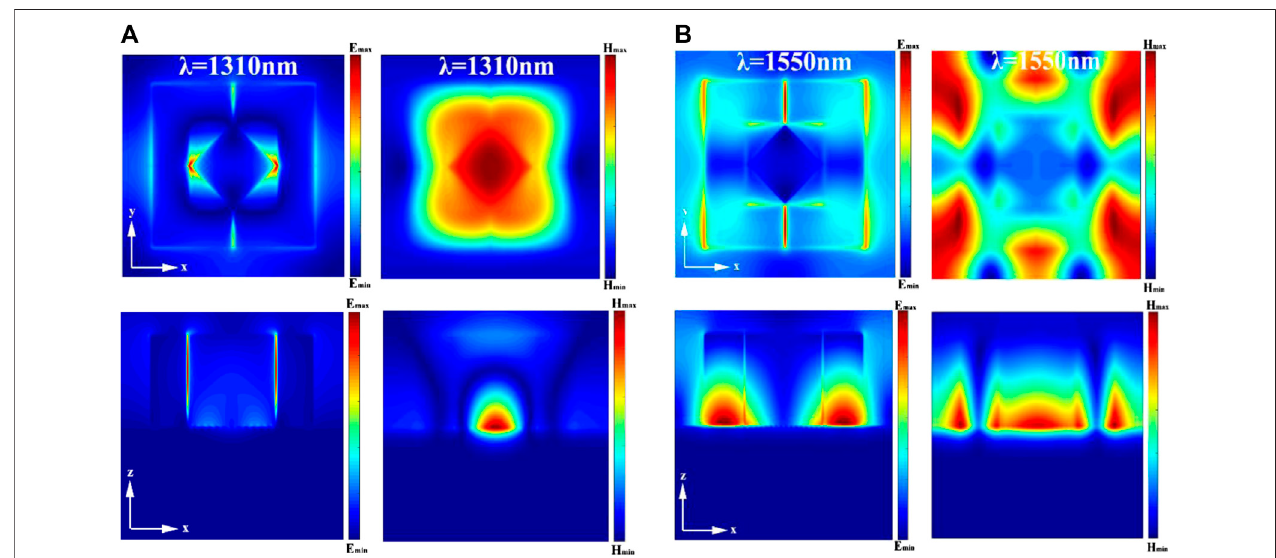
FIGURE 3 | Electric and magnetic fi eld intensity distribution diagram of the top planes (xoy) and cross-sectional planes (xyz) of the unit cell structure at the absorption peak of (A) 1310 nm, and (B) 1550 nm.